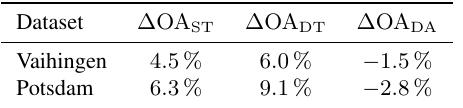
Table 2: Average values of ∆OA DA , ∆OA ST , ∆OA DT as de- fined in Section 4.1 over the Vaihingen and Potsdam